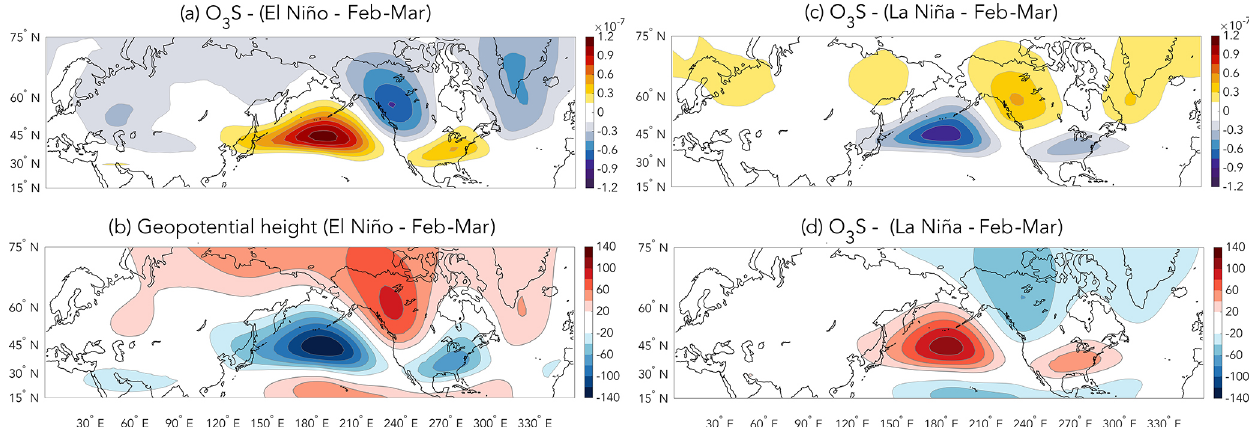
Figure 4. February–March (200hPa pressure level) anomaly composites of O 3 S (units: mass mixing ratio) for (a) El Niño and (b) La Niña and geopotential height (units: gpm) for (c) El Niño and (d) La